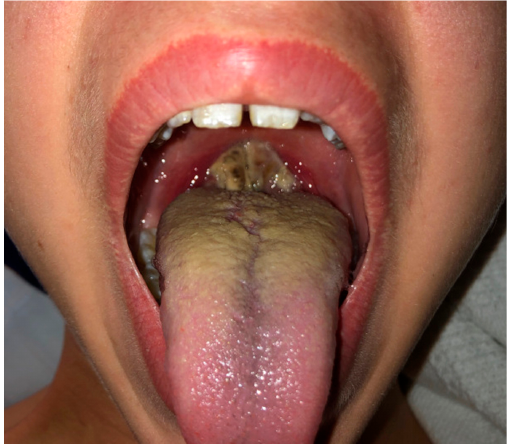
Figure 1. Oropharyngeal examination showing bilateral tonsillar enlargement with exudates.